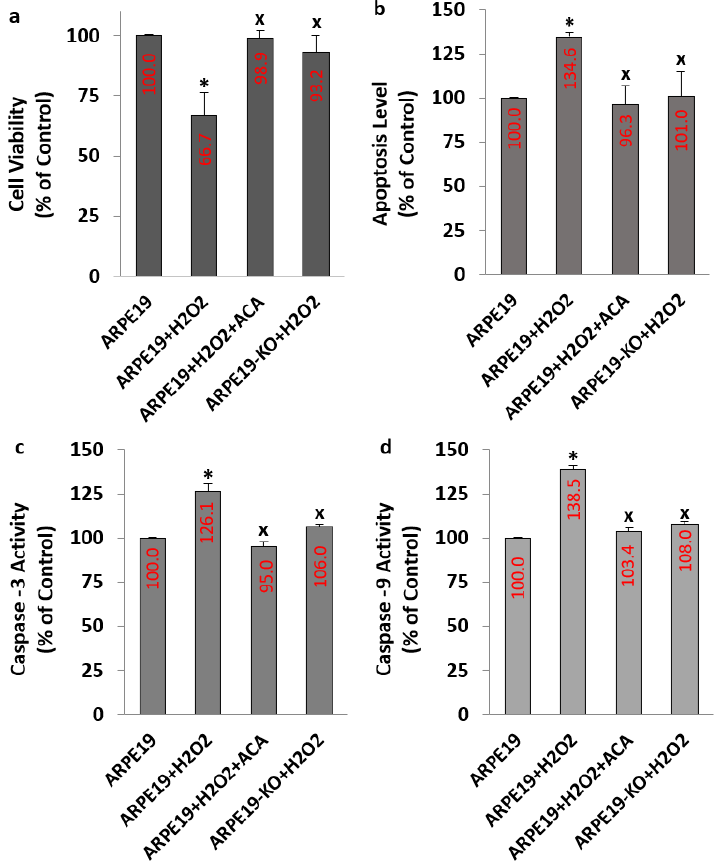
Figure 6. The values of apoptosis, caspase -3 (Casp -3), and -9 (Casp -9) were upregulated, although the values of cell viability were downregulated in the cells of ARPE19 (but not in the cells of ARPE19-KO) by the stimulation of H 2 O 2 . (Mean ± SD and n = 6). For analyzing cell viability, the test of MTT was used ( a ), whereas the value of apoptosis ( b ) was analyzed by using the ApoPercantage kit. The fluorogenic substrates of Ac-DEVD-AMC and Ac -LEHD-AFC were used for the assays of Casp -3 ( c ) and Casp -9 ( d ), respectively. (* p ≤ 0.05 vs. ARPE19. x p ≤ 0.05 vs. ARPE19 + H 2 O 2 ).